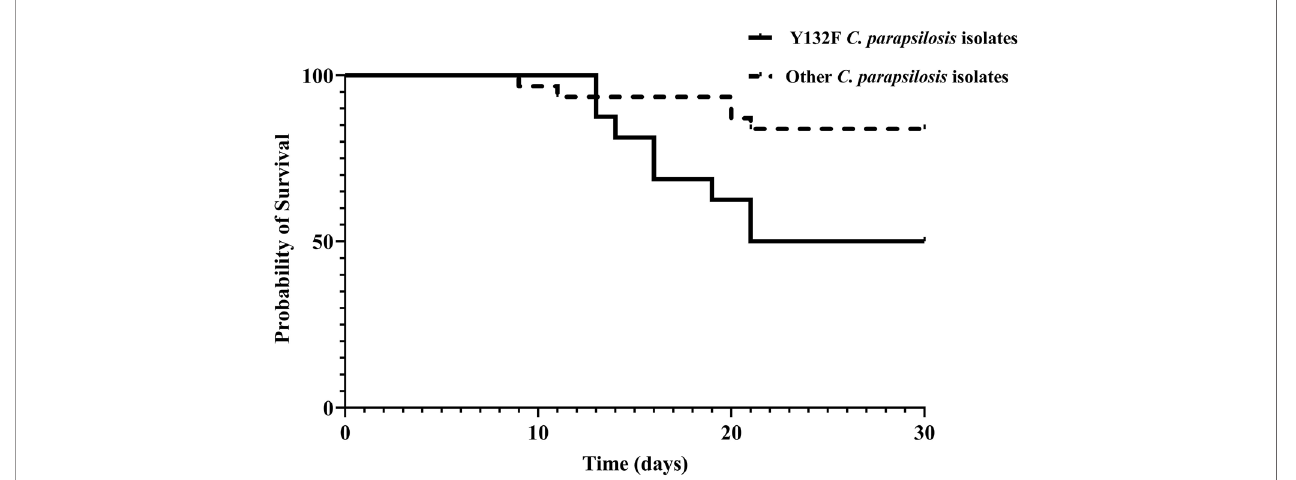
FIGURE 2 | 30-day survival of patients infected with azole-susceptible and azole-resistant C . parapsilosis isolates carrying Y132F in